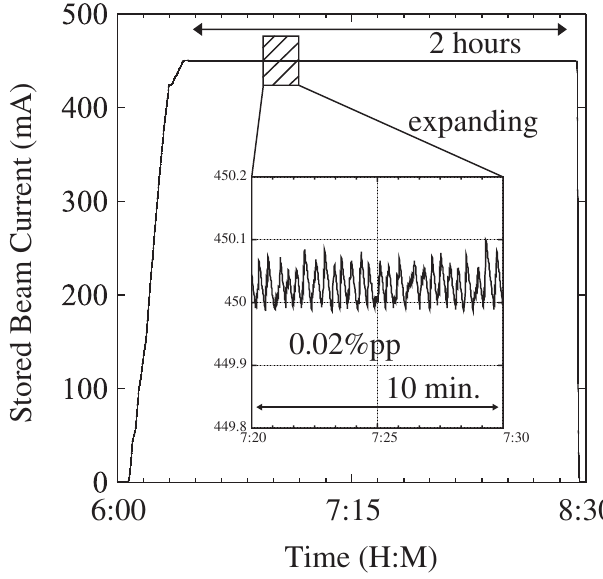
FIG. 19. Stability of the stored beam current for 2 hours during the top-up injection with the